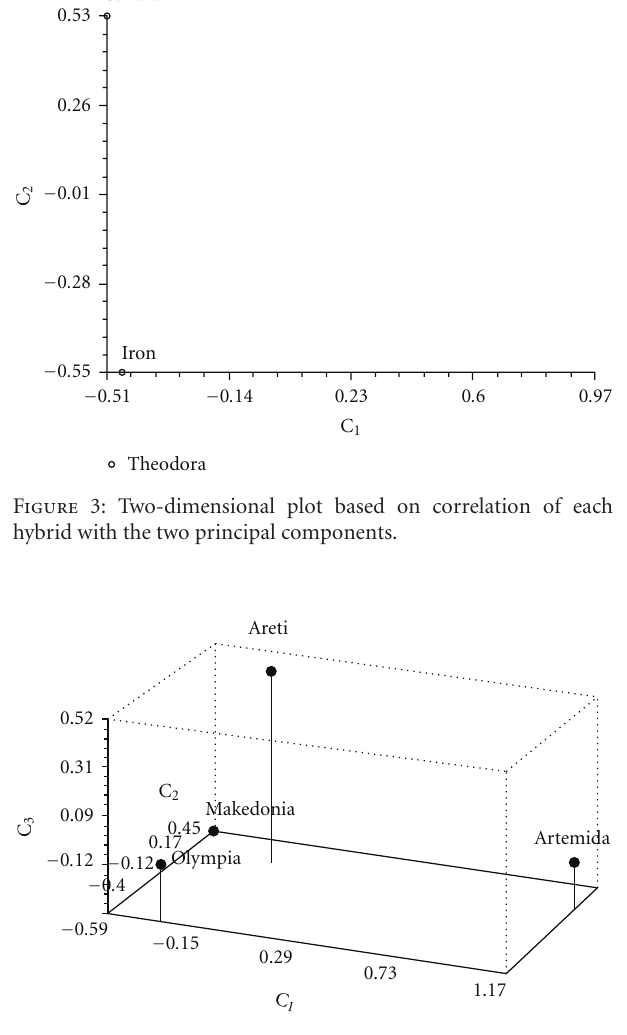
Figure 4: Three-dimensional plot based on correlation of each cultivar with the three principal components.